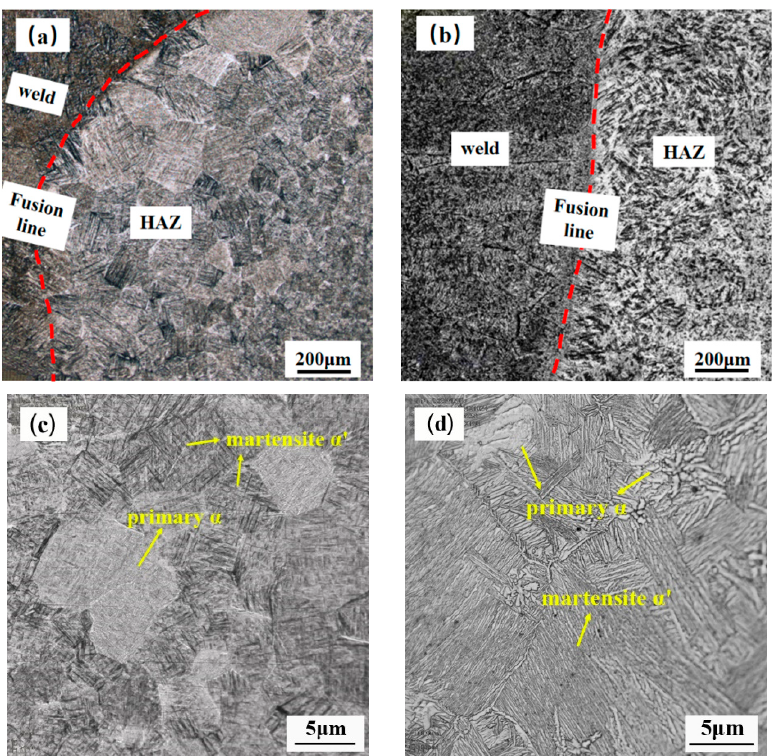
Figure 9. Metallograph near fusion line: ( a ) welding in air; ( b ) underwater welding; ( c ) local magnification, welding in air; ( d ) local magnification, underwater welding.